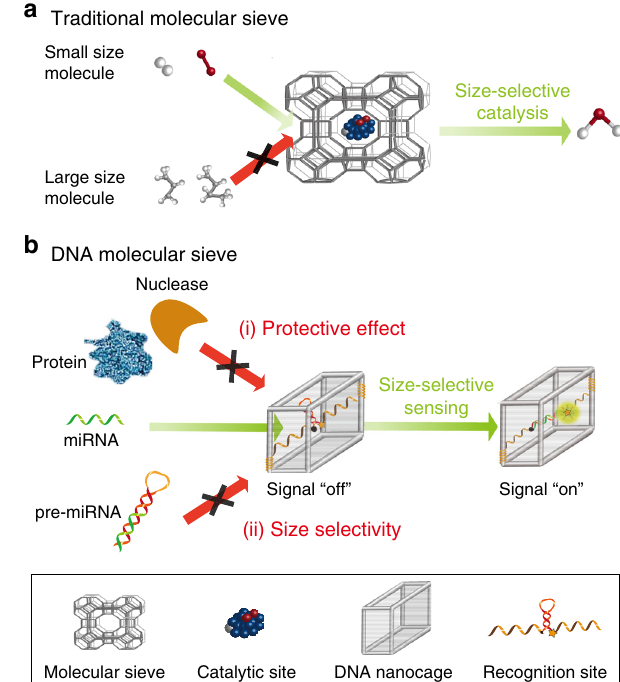
Fig. 1 Scheme illustration of DNA molecular sieve. a Size-selective catalysis based on a traditional molecular sieve. b Size-selective molecular recognition in the con fi ned space of DNA molecular sieve using cavity- tunable DNA nanocage framework nucleic acids. Large molecules, such as nucleases, proteins and larger analogues, are prohibited from contacting with inner recognition sites, while small target molecules are able to enter the cavity for ef fi cient molecular